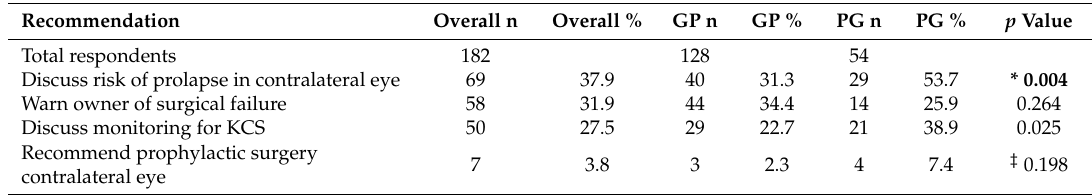
Table 5. Additional PNG management recommendations by GP and PG groups responding to a vignette questionnaire.